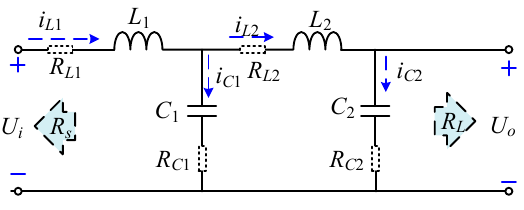
Figure 6. DC filter structure of the FRF.